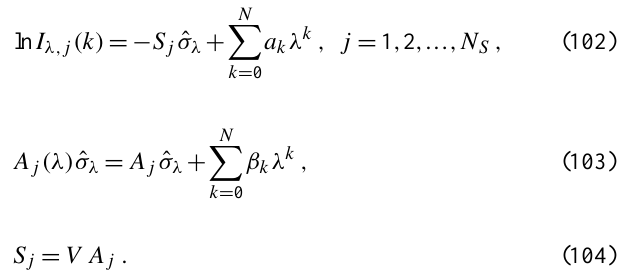
Figure 2. Relationship between different forms of the DOAS equations. Fig. 2. Relationship between different DOAS